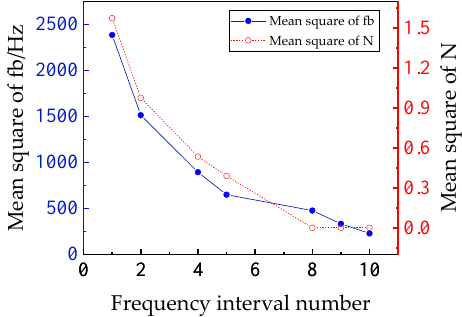
Figure 5. Mean square of f b and N with different frequency interval numbers.